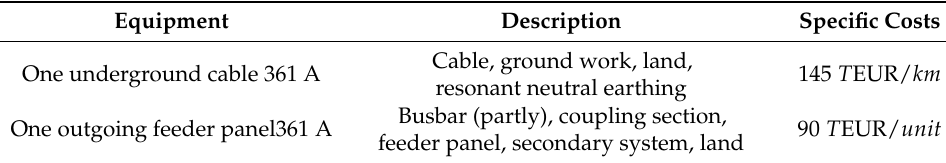
Table 6. Specific costs of the adopted standard grid expansion measures for MV grids